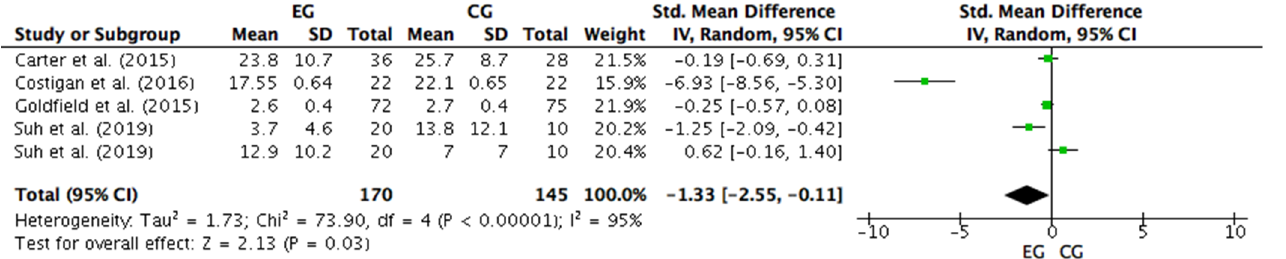
Figure 7. Forest plot comparing the effects of concurrent training on depression levels. EG: experimental group; CG: control group; SD: standard deviations.